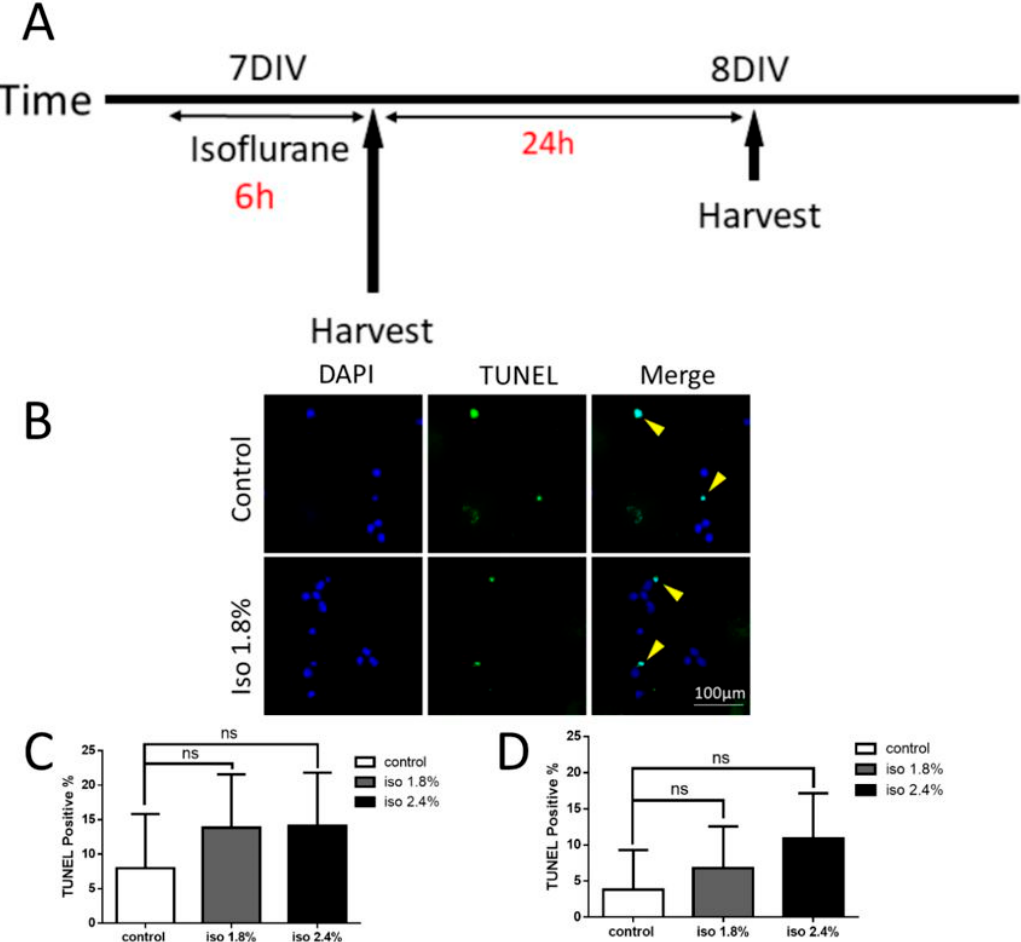
Figure 1. Isoflurane exposure at different doses did not show any significant apoptosis in our exposure paradigms. ( A ) The TUNEL experiment timeline in vitro. The neurons were exposed to either carrier gas or 1.8%/2.4% isoflurane for 6 h on their 7 DIV, and the cells were harvested immediately after exposure or 24 h after the exposure; ( B ). Representative images of DAPI (blue) and TUNEL (green) immunofluorescence in the dissociated neurons at 8 DIV; ( C , D ) 6 h of isoflurane treatment on 7 DIV did not show a significant apoptosis difference among all the DAPI/TUNEL neurons compared to the control groups immediately after the exposure ( C ) or 24 h after the exposure ( D ) ( n = 15 fields that were measured per group, n.s. indicates no significant difference, one-way ANOVA with Dunnett’s multiple comparisons test).